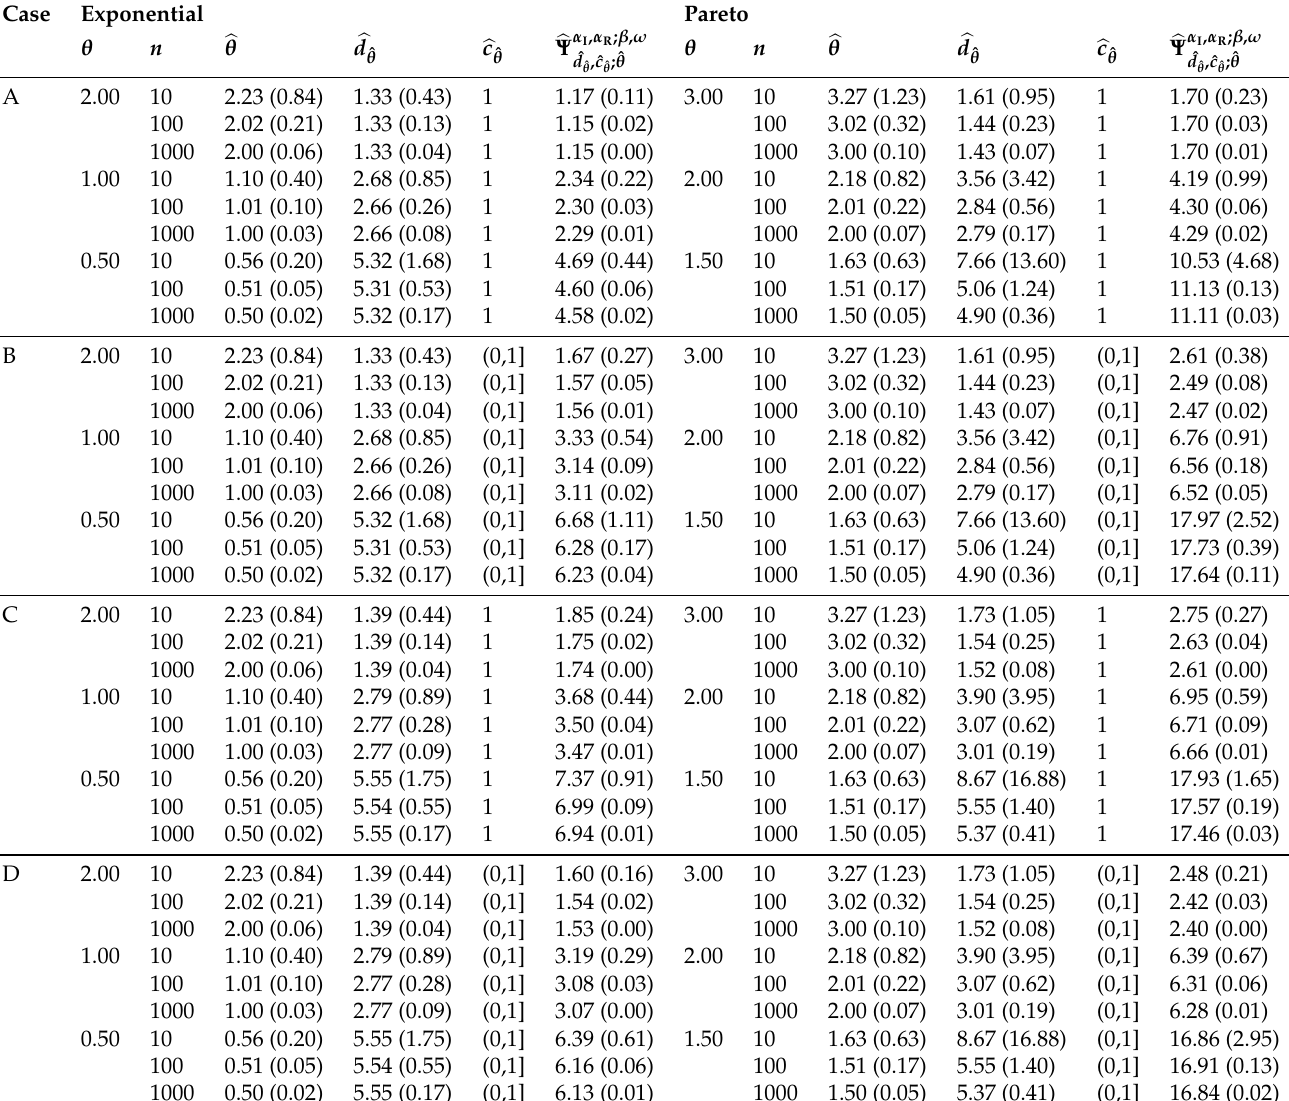
Table 1. The estimated optimal retentions for the combined stop-loss and quota-share reinsurance and the corresponding value of the minimized objective function when the initial loss follows an exponential or Pareto distribution. The RMSE of each estimate is given in parenthesis.